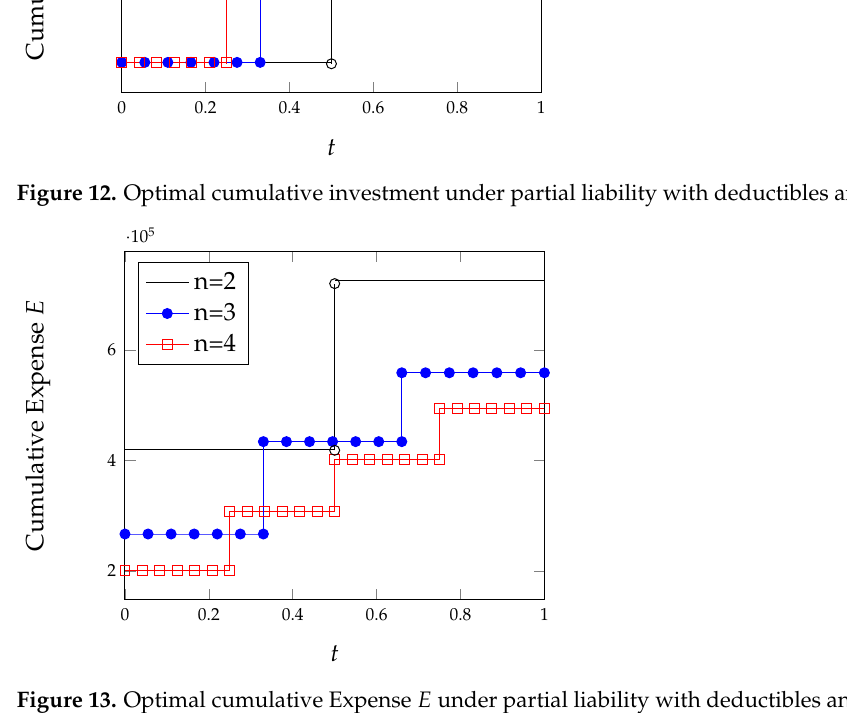
Figure 13. Optimal cumulative Expense E under partial liability with deductibles and GL2